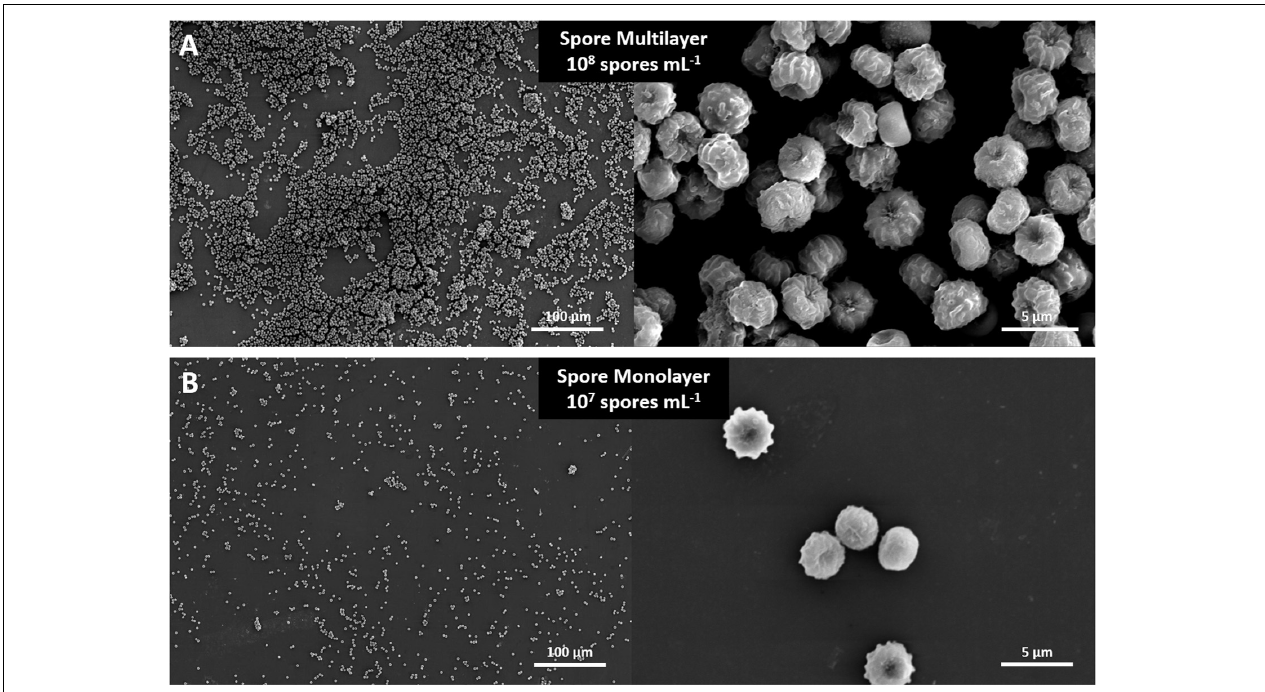
FIGURE 1 | SEM images of Aspergillus niger spores in (A) multilayer (10 8 spores mL − 1 ) and (B) monolayer (10 7 spores mL − 1 ).